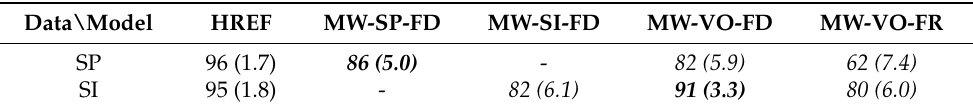
Table 3. Average rating and standard deviation for the perceptual evaluation of the perceived difference between original and resynthesis using different variants of the MBExWN model. The test data contains unseen phrases from voice identities (speakers/singers) that were used during